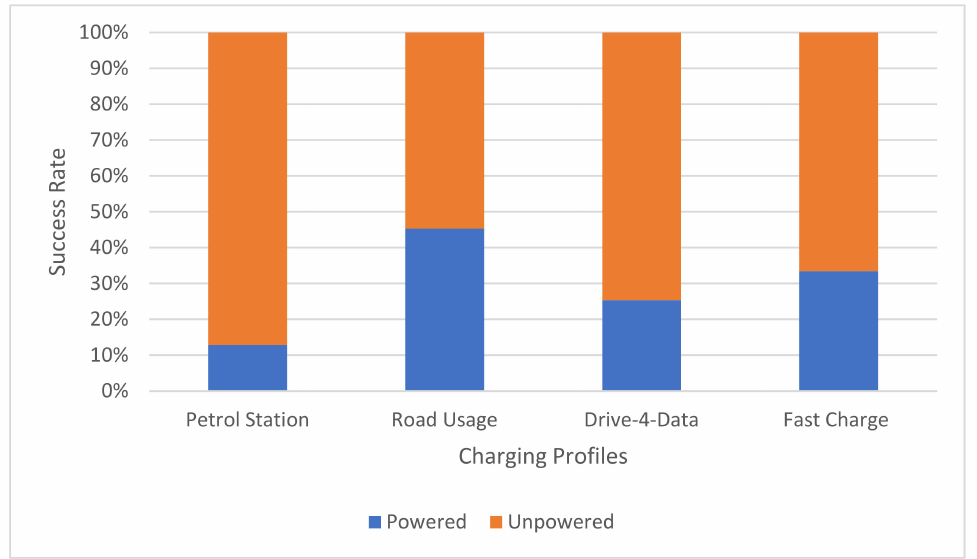
Figure 6. The success rate of the non-grid-connected system as a function of the charging